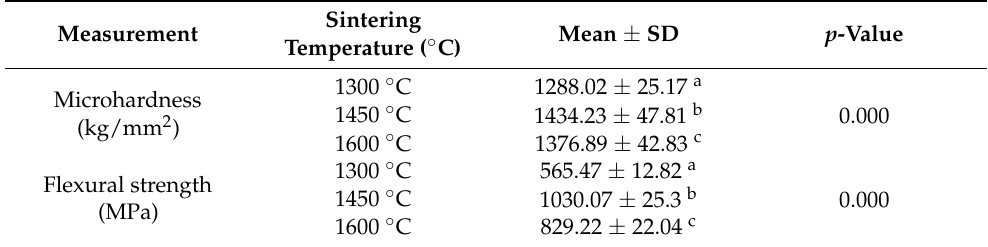
Table 3. Results of one-way ANOVA comparing the average Vickers microhardness of all the layers and flexural strength at different sintering temperatures followed by multiple comparison test (Dunnett